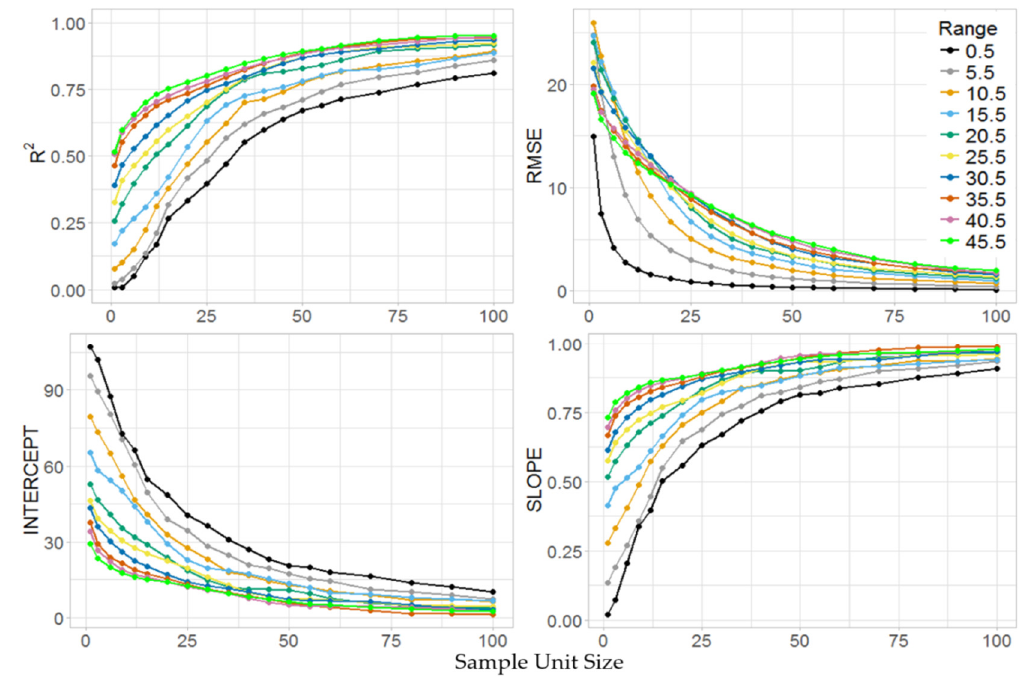
Figure 7. Stage I virtual NAIP image regression statistics for varying sample unit sizes and spatial correlation (Range), given average raster and GPS registration errors of 6 and 7 cells respectively. Actual NAIP image regression statistics are shown in Figure A2.